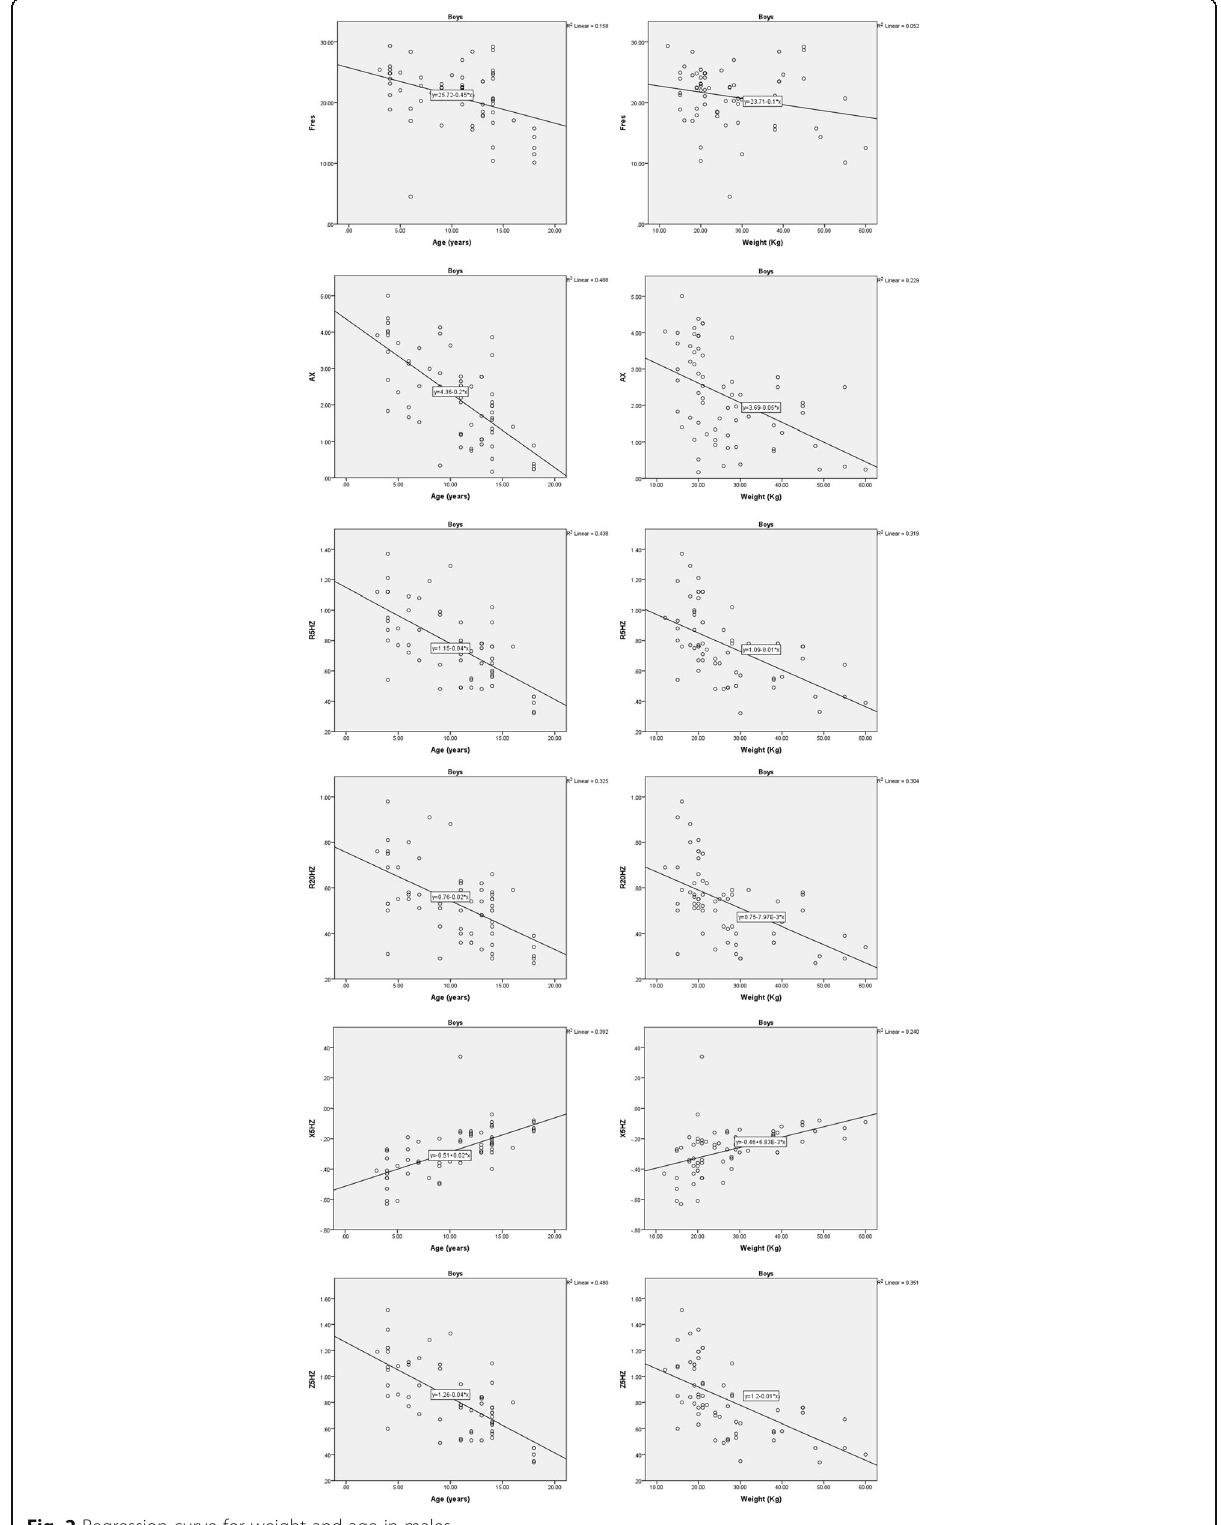
Fig. 2 Regression curve for weight and age in